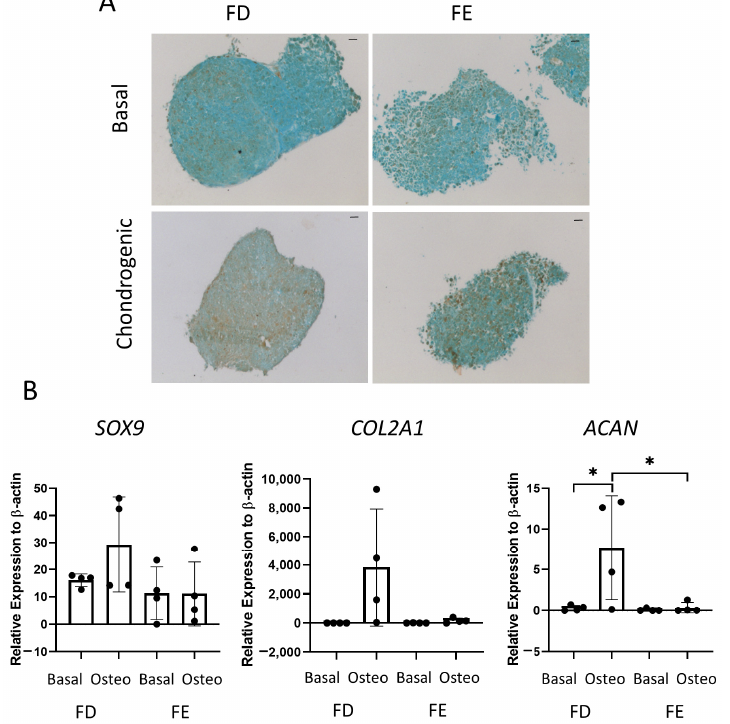
Figure 5. Chondrogenic differentiation of HBMSCs from two regions of the femur. Cell pellets of FD and FE HBMSCs were cultured in basal or chondrogenic media for 28 days. ( A ) SOX9 staining of basal and chondrogenic cultured cell pellets. SOX9 stained brown, proteoglycans stained blue with alcian blue, Scale bar = 100 µm. ( B ) Gene expression analysis of SOX9, aggrecan (ACAN), and collagen II (COL2A1) as a relative expression to β -Actin were performed by qPCR for FD and FE HBMSCs ( n = 4, symbols refer to individual patient samples with three technical replicates). Results presented as +/ − SD, significance determined using a one-way ANOVA, significance presented as * <